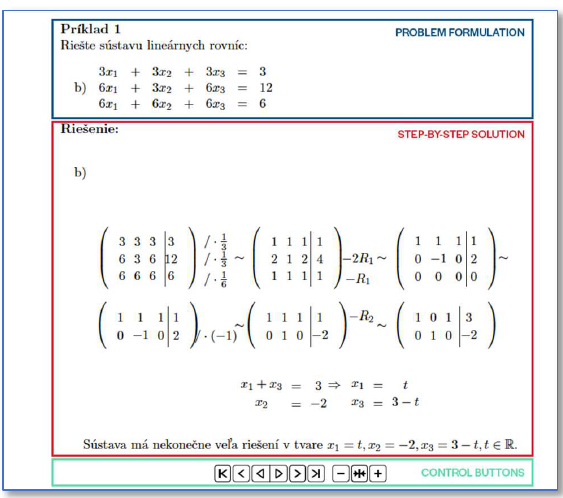
Figure 4. An example of an interactive PDF document with step-by-step explanations to a sample solution. Color frames denoting separate areas are added for clarity.